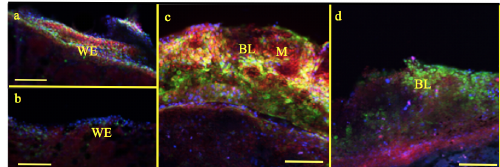
Figure 6. mPTP staining: Wound epithelium (WE) at 24 h as well as 5 day blastema (BL) of experimental tadpoles show increased staining for mitochondria as well as open mitochondrial pores (Figure 6a,c) compared to control (Figure 6b,d). Mitochondria (M)—red; mPTP open—yellow (calcein has